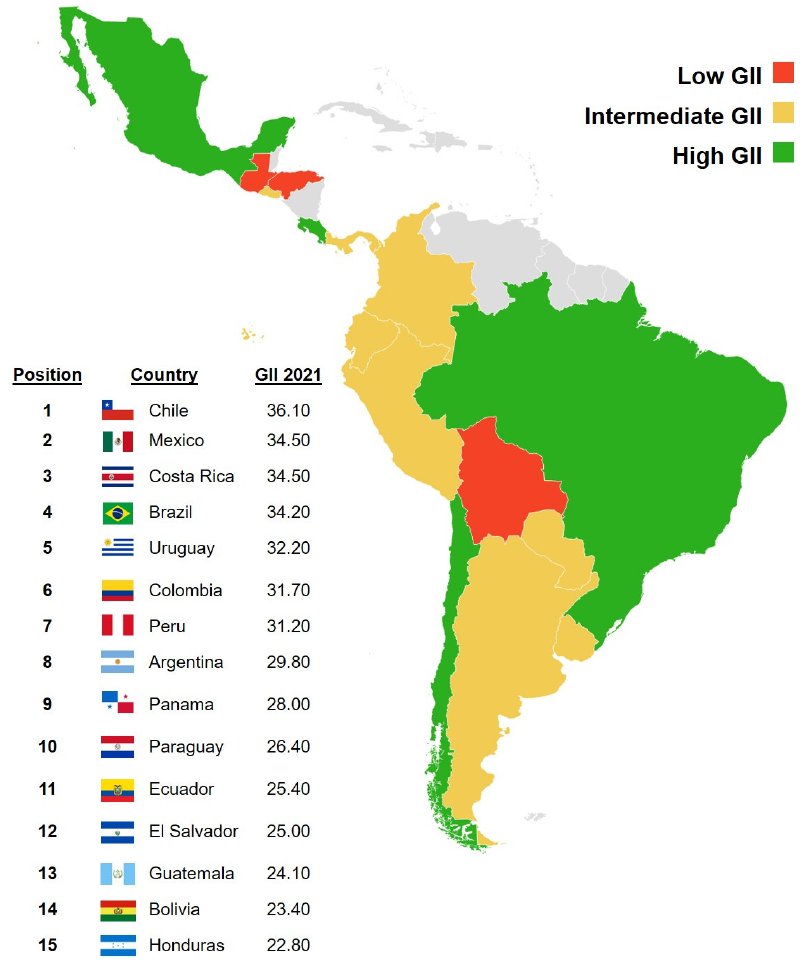
Figure 1. GII rank for Latin American and the Caribbean countries in 2021 whose GII is computed.